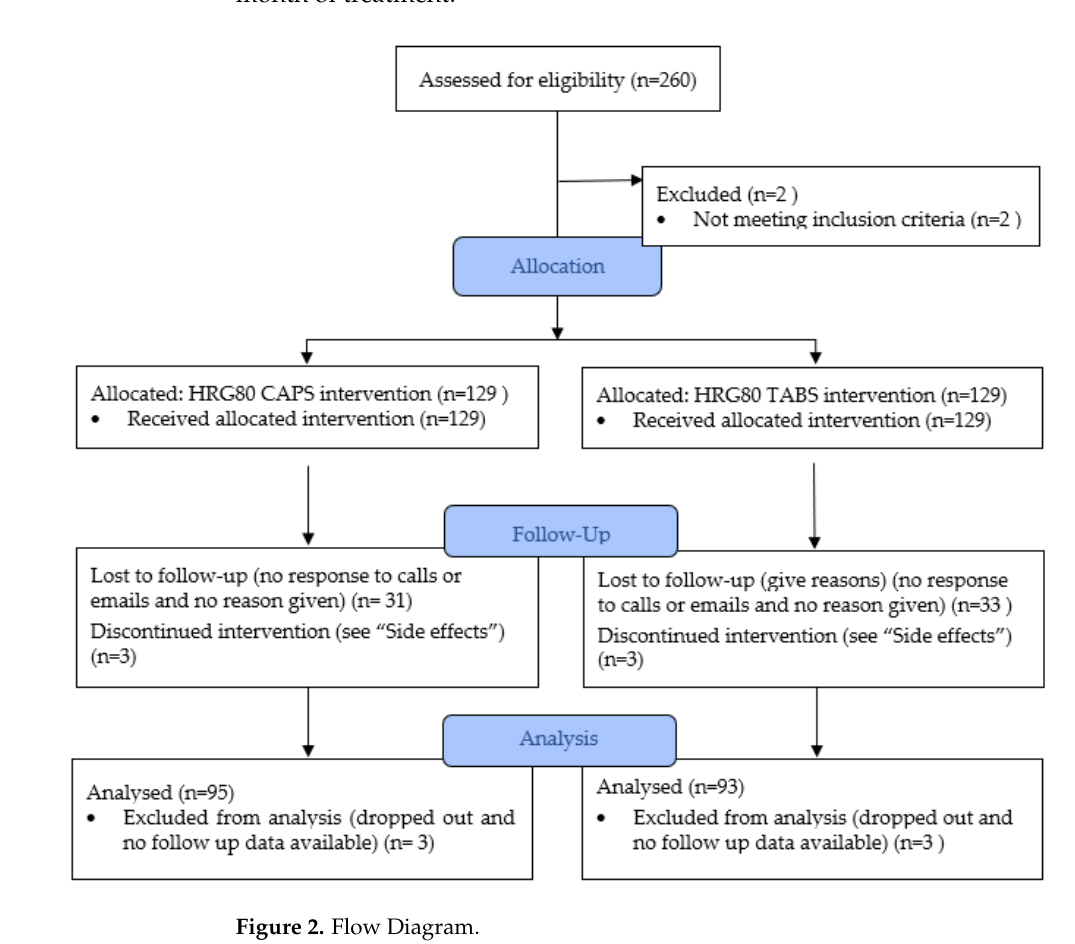
Figure 2. Flow Diagram.